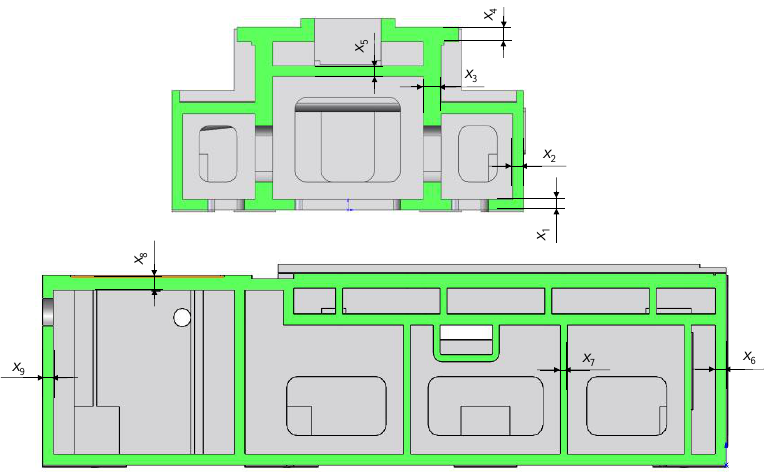
Figure 8. Sectional sketch for the design variables.